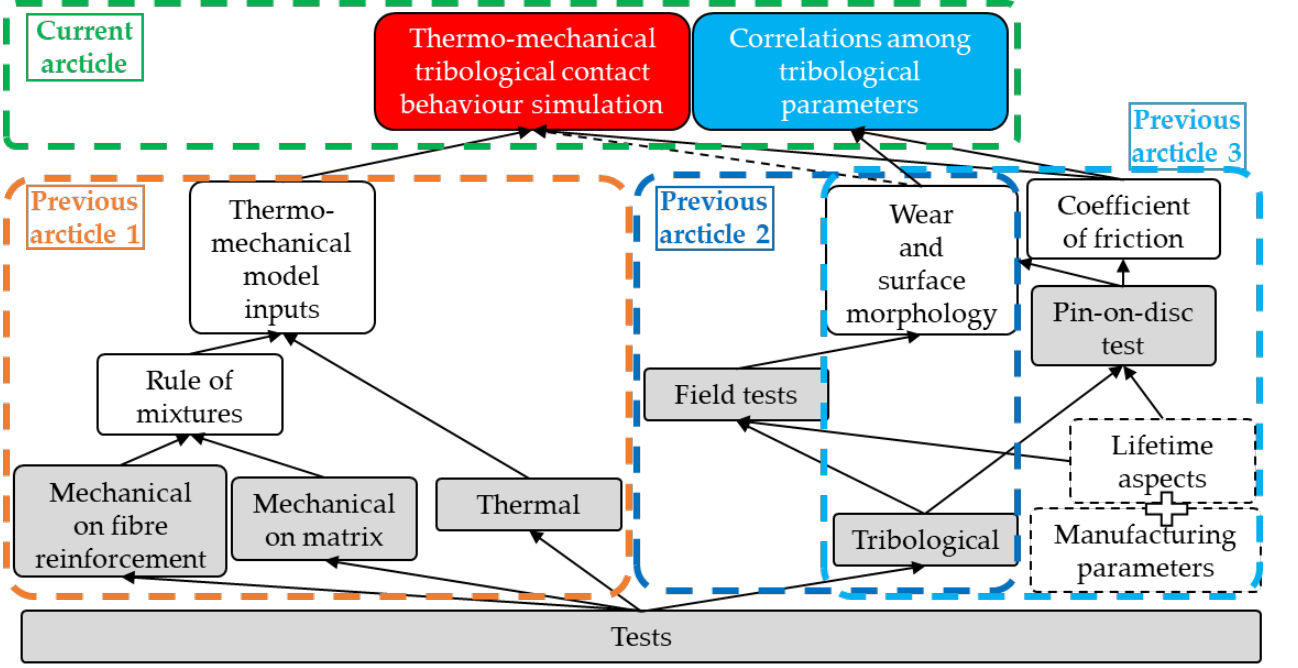
Figure 1. Tribo-thermomechanical characterization and modeling method.